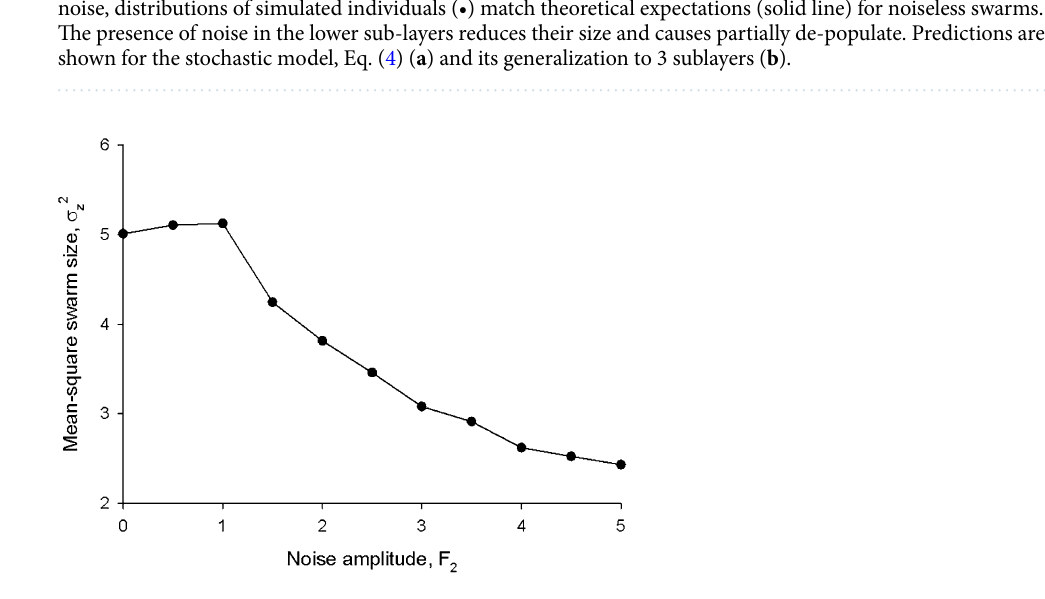
Figure 8. Swarms are predicted to compress in response to external dynamic perturbations. Predictions were obtained using the stochastic model, Eq. (4), for the bipartite swarm shown in Fig.